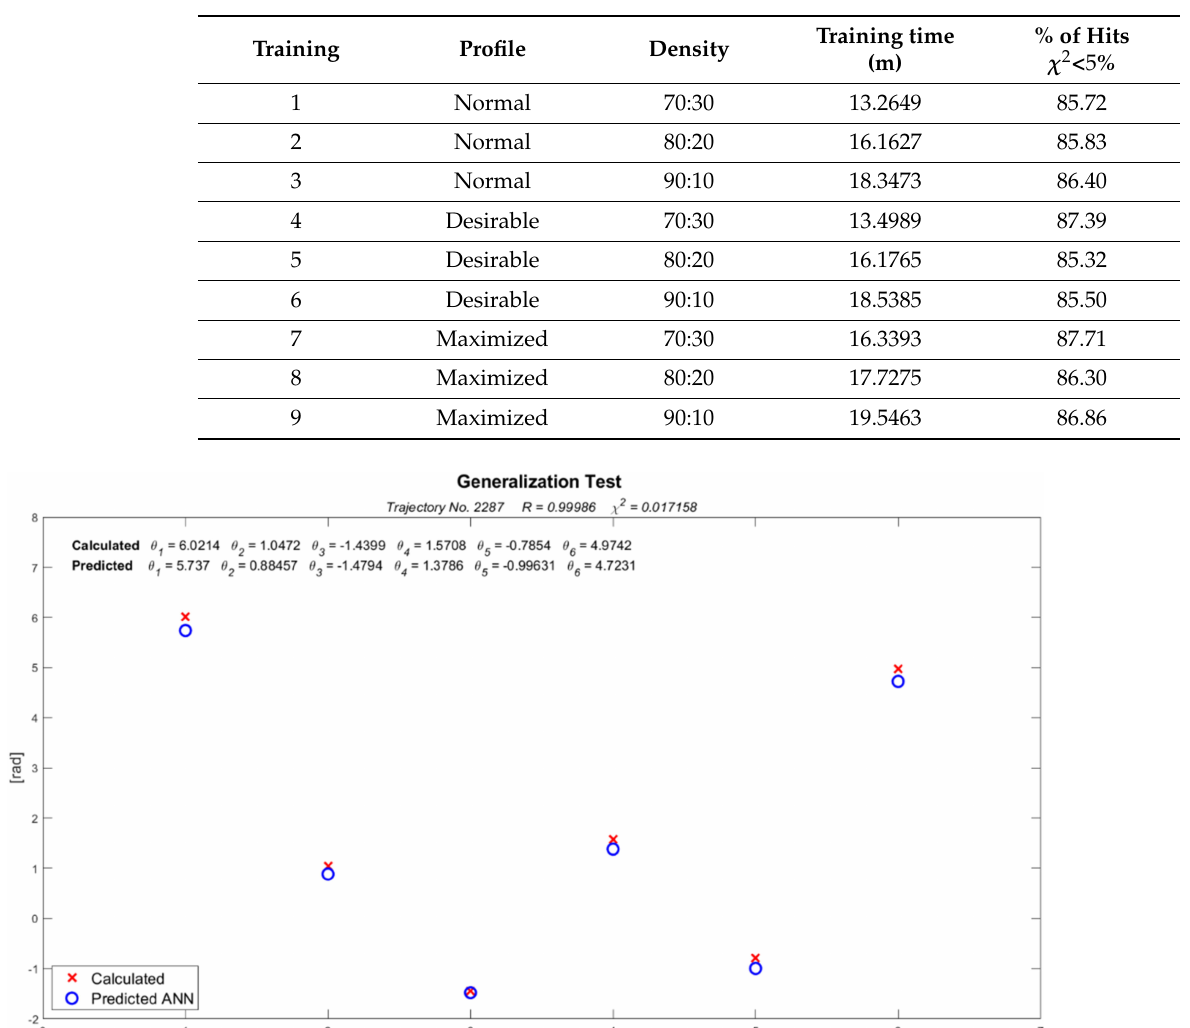
Table 8. Comparison of density and percentage of hits in the three best profiles.